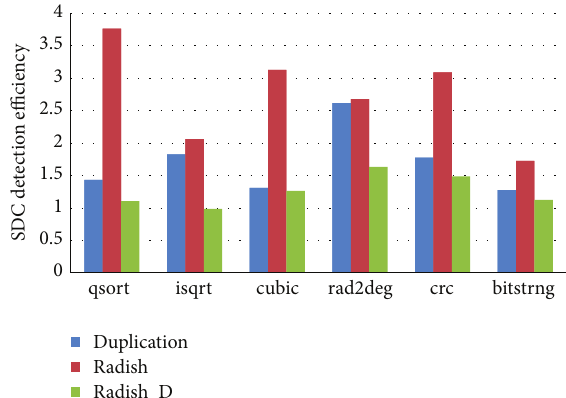
Figure 6: The comparison of SDC detection efficiencies among full instruction duplication, Radish, and Radish D.